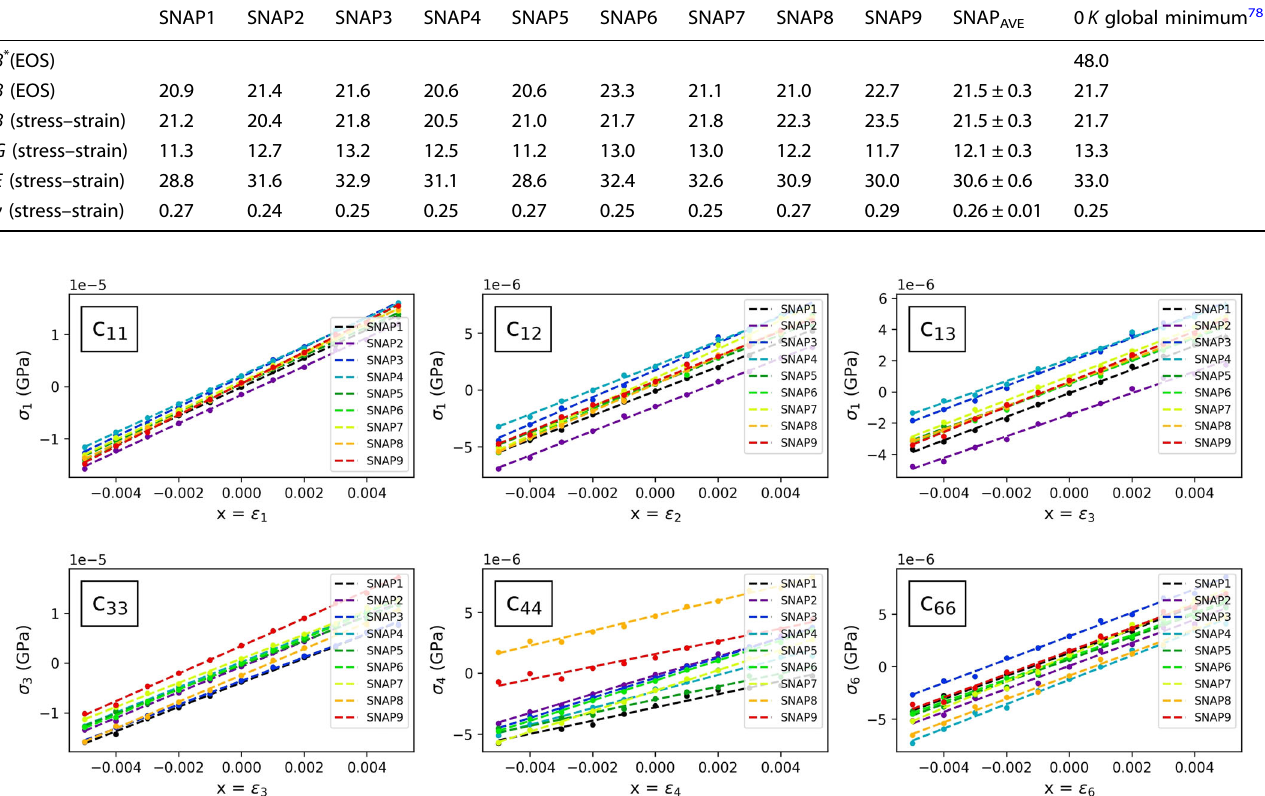
Fig. 8 Stress – strain relations (Equations (18) and (19)), with linear fi ts providing the components c 11 , c 12 , c 13 , c 33 , c 44 , and c 66 of the elastic tensor from Equation (19), for the same nine fully relaxed snapshots from the 600 K- NPT CP molecular dynamics of t-LGPS as in Fig. 7. At each value of the strain parameter x the stress is calculated by relaxing the atoms. The full elastic tensors for the nine con fi gurations are reported in Supplementary Tables 2 – Voigt-Reuss bounds for each relaxed snapshot con fi guration, and